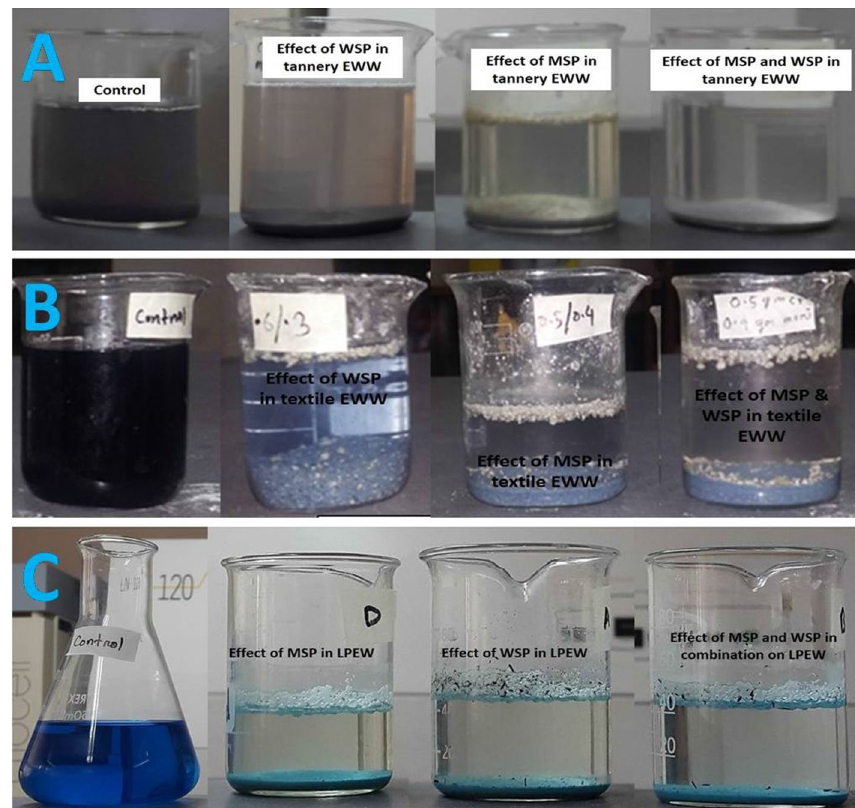
Fig. 1 Discoloration effects of MSP and WSP on different EWW ( a textile IWW; b tan- nery IWW; c challenge test with